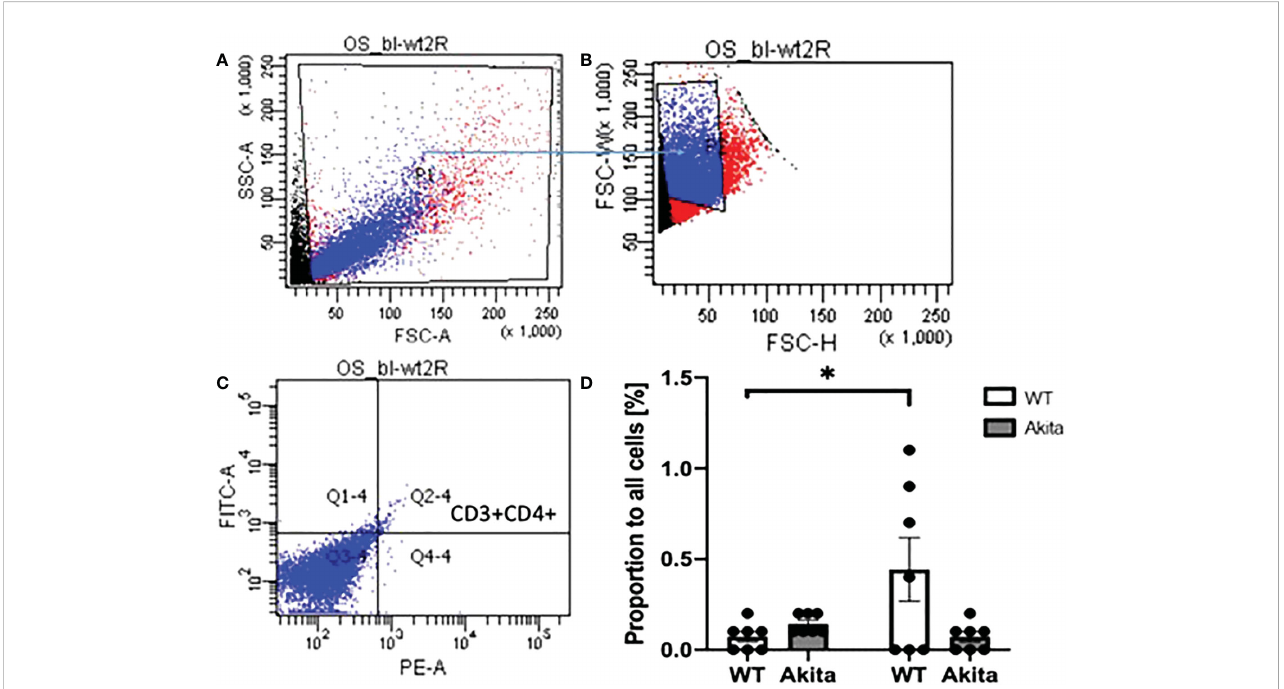
FIGURE 9 Proportion of CD3+CD4+ T cells in lymphocytes in ocular surface samples of WT and Akita mice at baseline and day 3 after corneal alkaline injury. (A) Gating of lymphocytes (P1). (B) Gating of single cells against double or multiple cells (P2). (C) Gating of CD3+CD4+ T cells (Q2 – 4). (D) Using a paired t -test, WT mice had a signi fi cant increase of CD3+CD4+ T cells on the ocular surface at day 3 after CABI as compared to baseline ( n = 7, p = 0.0471), whereas no signi fi cant change was observed in CD3+CD4+ T cells on Akita mice ocular surface after injury ( n = 7 for both the WT and Akita groups, p = 0.0941).